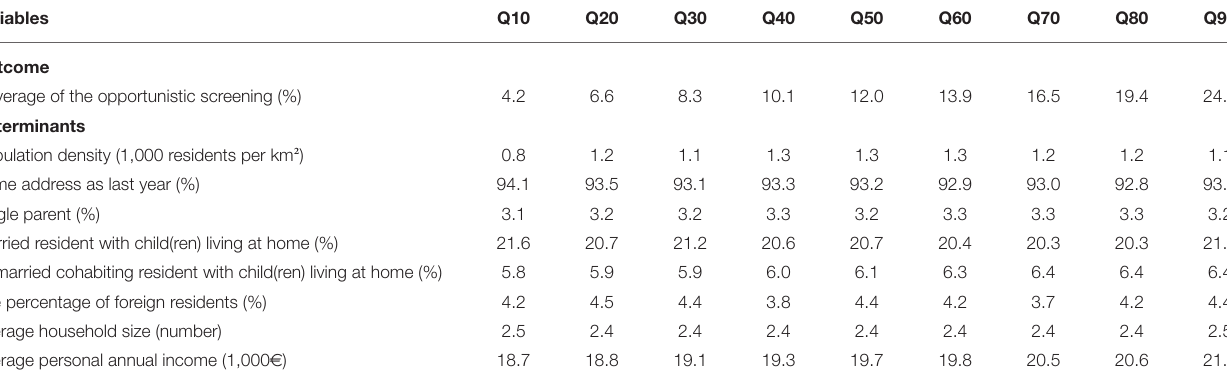
TABLE 2 | Description of the neighborhood-level socio-demographic variables and coverage of the opportunistic screening at the 10th (Q10) to the 90th (Q90) quantiles * . Variables Q10 Q20 Q30 Q40 Q50 Q60 Outcome Coverage of the opportunistic screening (%)